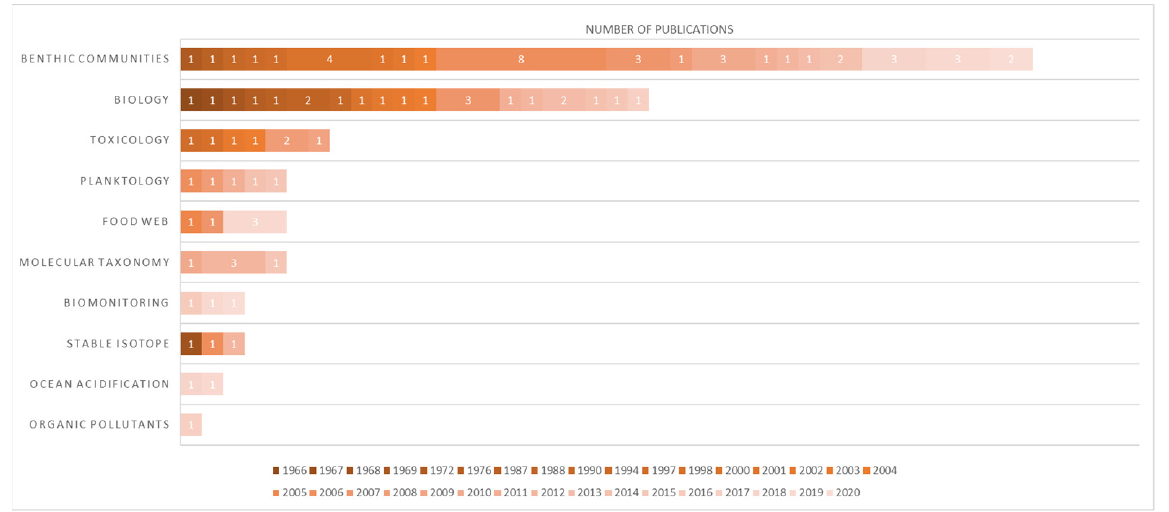
Figure 7. Graphical ranking representation of the 93 publications analyzed for this work for the Ross Sea. Each paper was classified into a general category. The publications are color-coded based on the year of publication (which runs from 1966 to 2020). The data refer to available literature in February 2022.